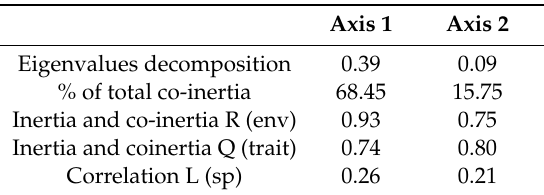
Table 4. Summary of the RLQ analysis results. The table presents the eigenvalues and percentage of total co-inertia, the ratio of inertia and co-inertia for R (the environmental variable matrix), Q (the species traits matrix) and correlation with the L matrix (species), for Axis 1 and Axis 2.